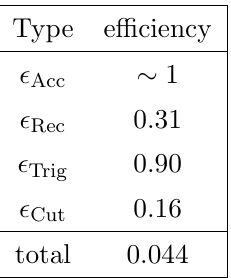
Table 1 . The cuts used in the analysis with their e(cid:14)ciency (cid:15) cut and uncertainties on these e(cid:14)cien- p cies (cid:14)(cid:15) cut = (cid:15) (1 (cid:0) (cid:15) ) N , where N is the total number of events. The analysis was performed on 100K SM simulated events.